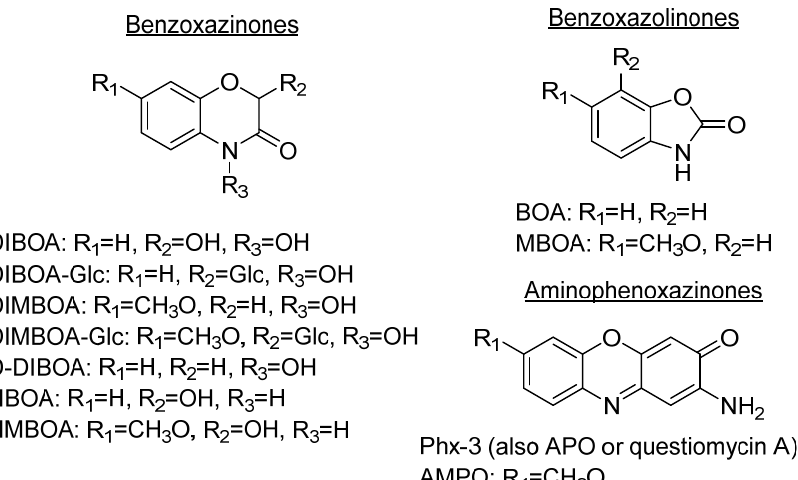
Figure 1. Prominent benzoxazinones and some of their degradation products.